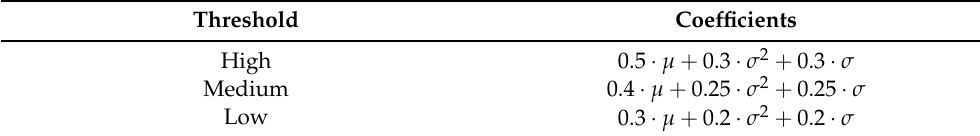
Table 4. Thresholds in Post-processing.